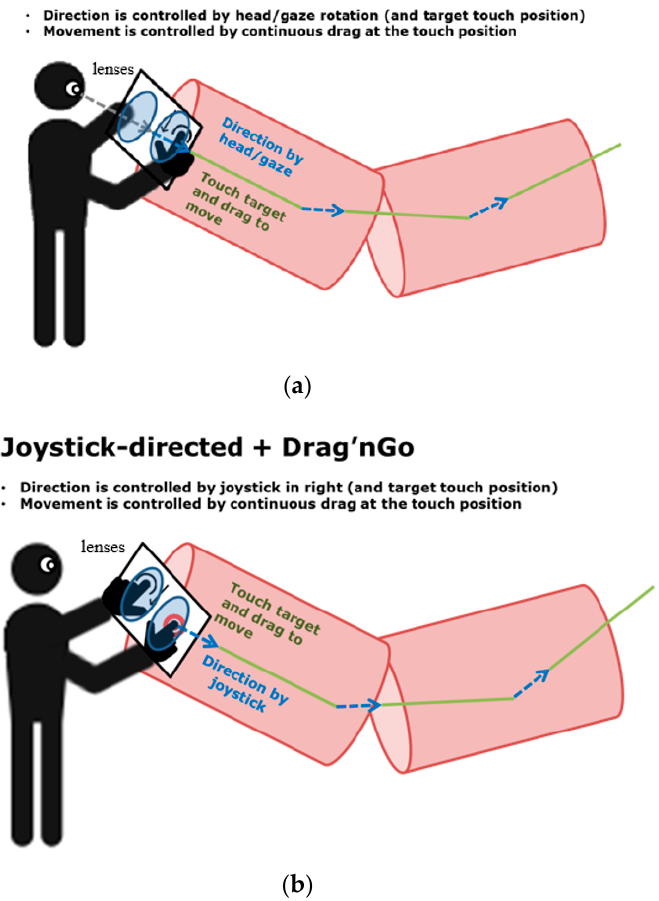
Figure 5. Head-directed + Drag’n Go (HD + DG) ( a ) and joystick-directed + Drag’n Go (JD + DG) ( b ). The red cylinders represent the virtual tunnel segments through which the user needs to navigate in the experimental task. For both interfaces the Drag’n Go method is used to control the user’s movement toward the point of interest proportionally to the amount of the drag. For HD + DG, the user’s head orientation sets the movement direction and for JD + DG, the virtual joystick on the right.